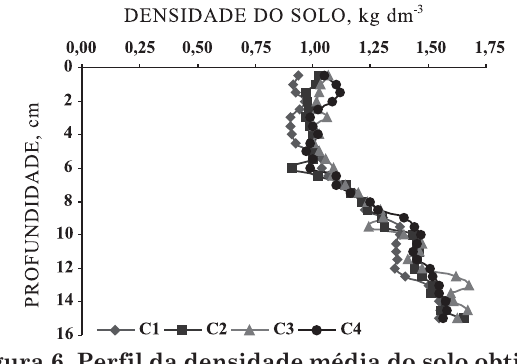
Figura 6. Perfil da densidade média do solo obtida por tomografia computadorizada para o teor de água do solo U = 0,36 kg kg -1 , em razão das cargas aplicadas (C1 = 0 N, C2 = 50 N, C3 = 90 N e C4 = 140